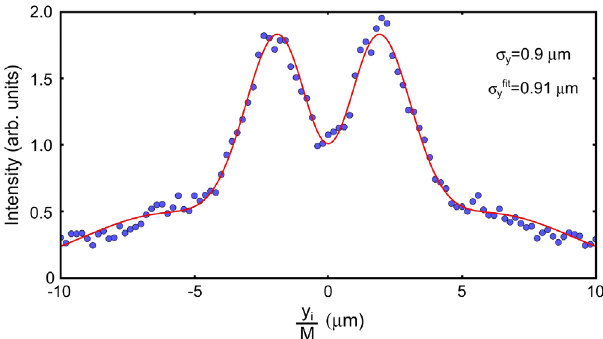
FIG. 12. Comparison of beam profile data (blue points) with fit function Eq. (13) (red solid line) under real experimental conditions. For the profile the data from Fig. 8 were taken for a beam size of σ y ¼ 0 . 9 μ m and a random noise was